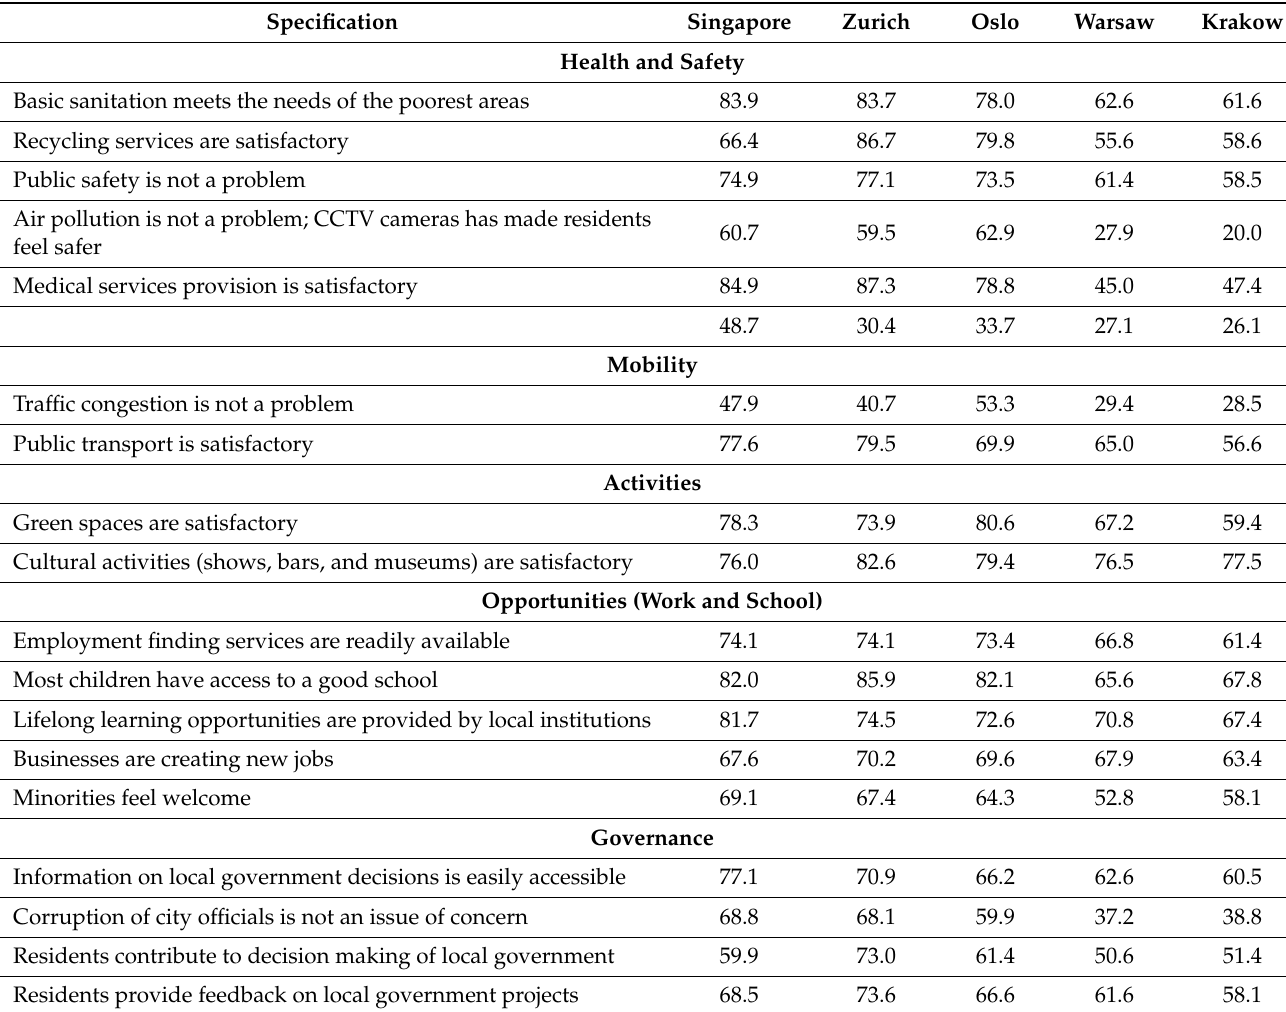
Table 2. A cumulative list of smart city scoring on the basis of the IMD-SUTD Smart City Index (SCI)—structural factors [85].